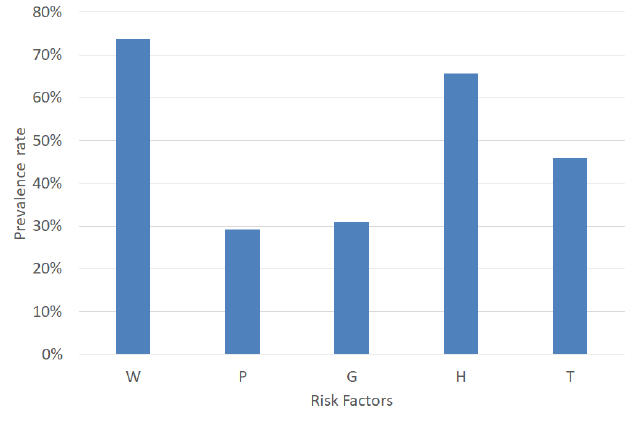
Figure 9. Prevalence rate of the MetS risk factors using the dataset with oversampling.